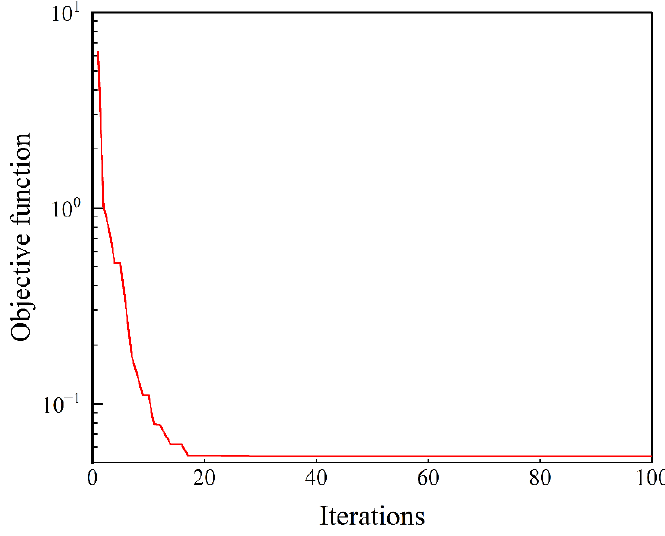
Figure 2. Convergence of the objective function with the number of iterations of the algorithm.